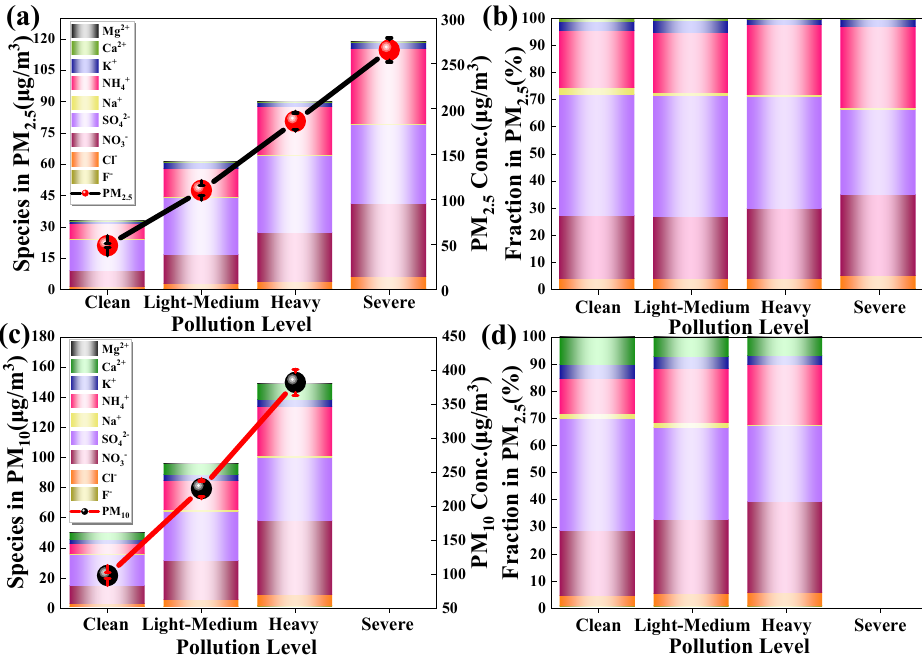
Figure 5. ( a , b ) are the content and percentage of water-soluble ions in PM 2.5 at different pollution levels, respectively; ( c , d ) are the content and percentage of water-soluble ions in PM 10 at different pollution levels.